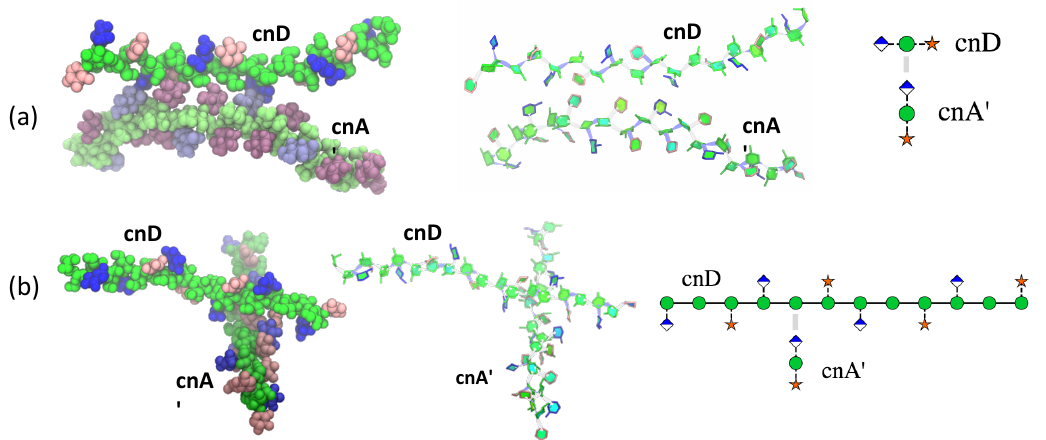
Figure 6. Examples of self-aggregation interactions between 6-RU strands of cnD and cnA in ( a ) parallel and ( b ) orthogonal arrangements. Molecules are depicted using the VMD [26] van der Waals representation (left); and the VMD PaperChain and Twister representations (middle) and a schematic (right). The saccharide residues are coloured as follows: α DMan—green; β DGlcA—blue; β DXyl—pink; and